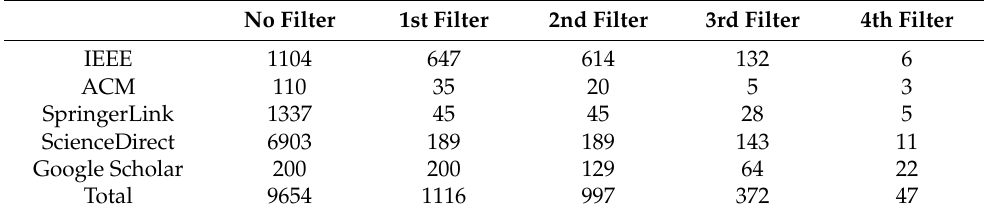
Table 1. Results of the Filtration